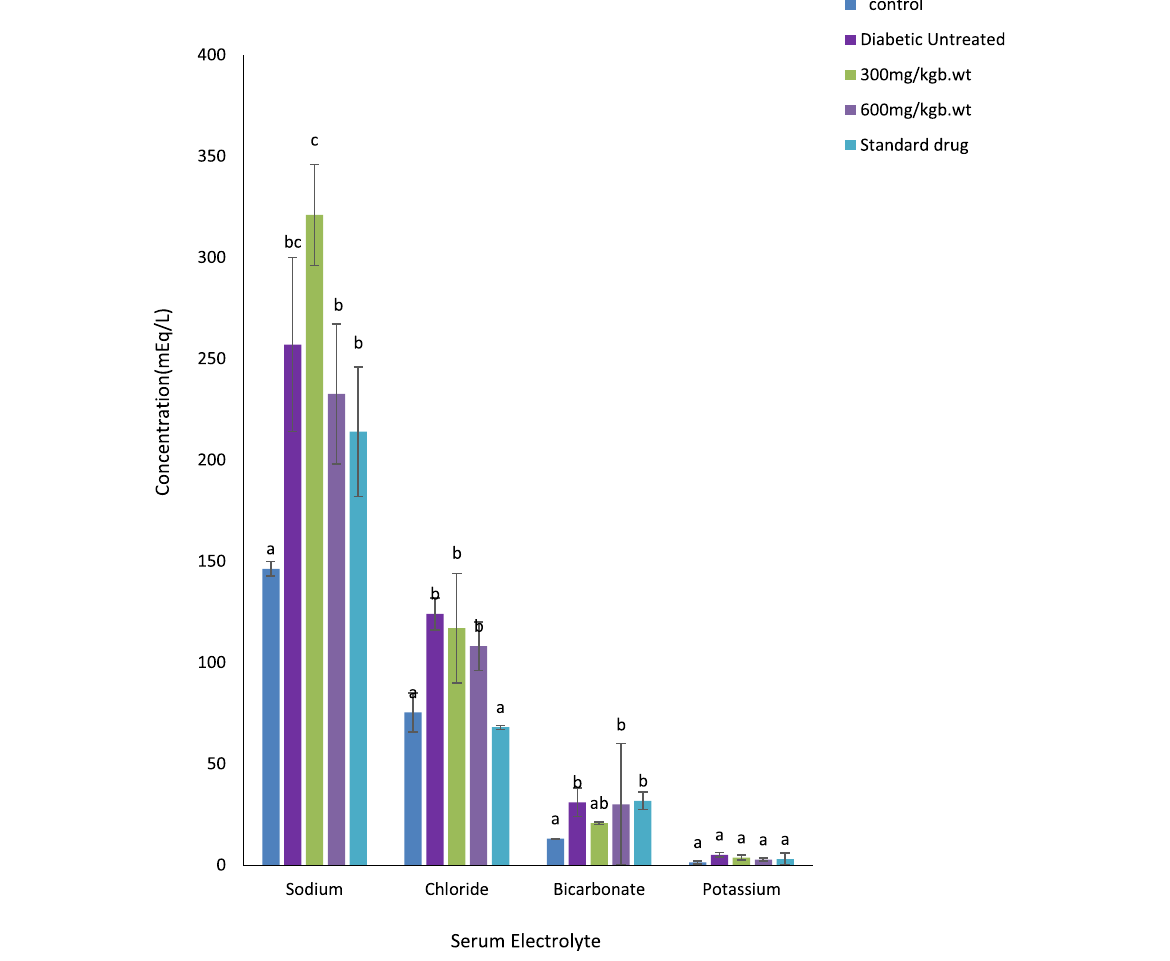
Fig. 5 Effect of Methanol Root Extract of Chromolaena odorata on Serum Electrolyte in Alloxan Induced Diabetic Rats. Each bars represents Mean ± SEM of triplicate determinations. Bars with different alphabets indicate significant difference at ( p <